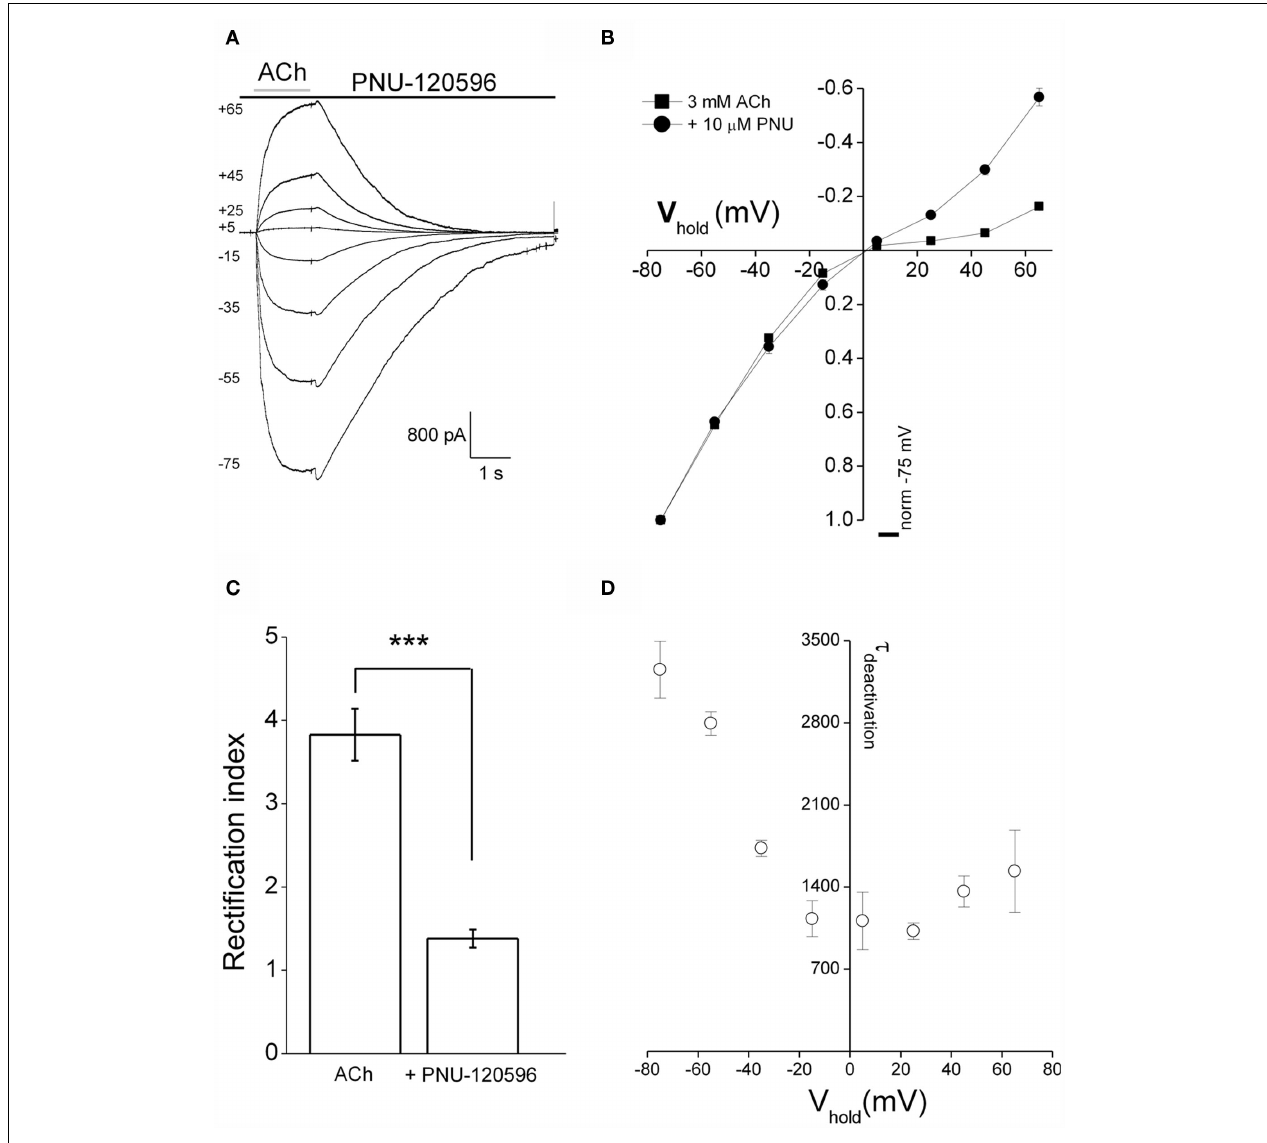
presence of PNU120596 ( n = 5). Rectification index is defined as the chord conductance between − 75 and − 55mV divided by that between + 45